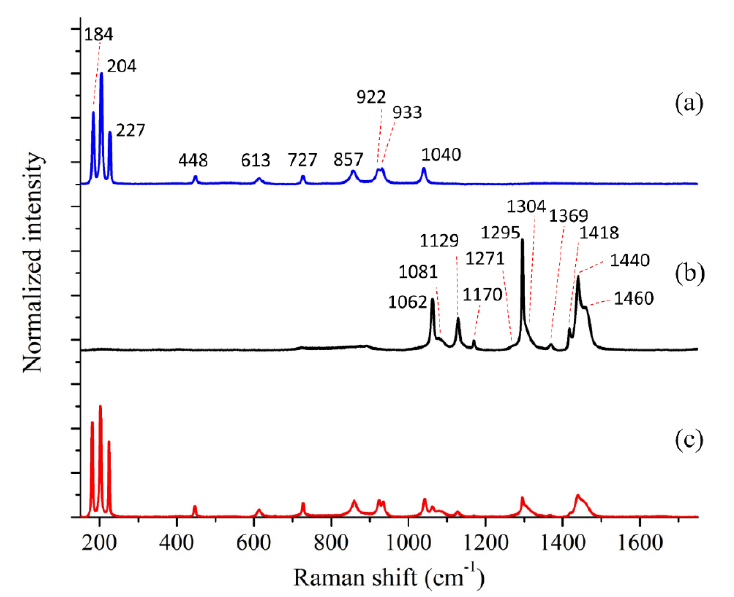
Figure 4. Raman spectra of 3 different samples: ( a ) bulk Si 3 N 4 , ( b ) PE substrate, and ( c ) Si 3 N 4 -coated PE substrate.